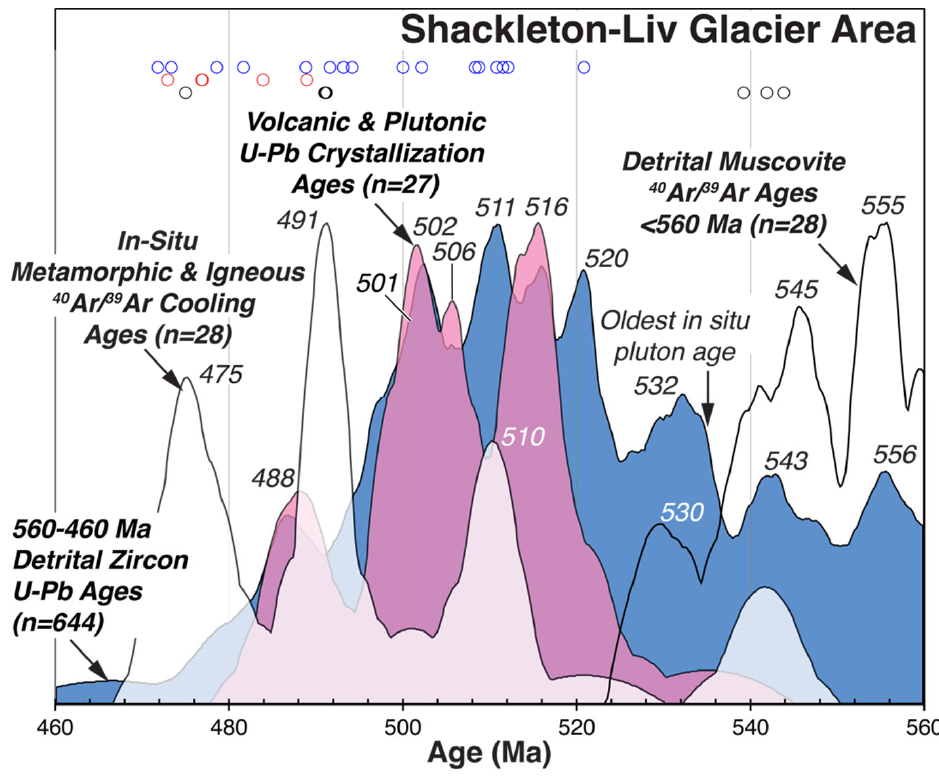
Figure 9. Stacked kernel-density-estimation diagrams [73] showing in situ igneous and metamor- phic 40 Ar/ 39 Ar cooling ages, detrital zircon U-Pb ages, volcanic and plutonic U-Pb crystallization ages, and detrital muscovite 40 Ar/ 39 Ar ages falling within the 560–460 Ma time period from the Shackleton Glacier area (Ramsey to Liv glaciers) of the Ross orogen. 40 Ar/ 39 Ar age contributions from hornblende (blue circle), muscovite (red circle), and biotite (black circle) are shown above the cumulative KDE diagram for in situ igneous and metamorphic 40 Ar/ 39 Ar cooling ages. In situ igneous and metamorphic 40 Ar/ 39 Ar cooling ages are compiled from data presented in this paper, as well as [45,46,48,51,54]. Detrital zircon ages are compiled for the Liv and Beardmore groups from [26,27,54]. Volcanic and plutonic U-Pb crystallization ages are compiled from data presented in [33–36,44,45,47,48]. 40 Ar/ 39 Ar ages for detrital muscovite from the Starshot Formation along Ramsey Glacier are from [45].